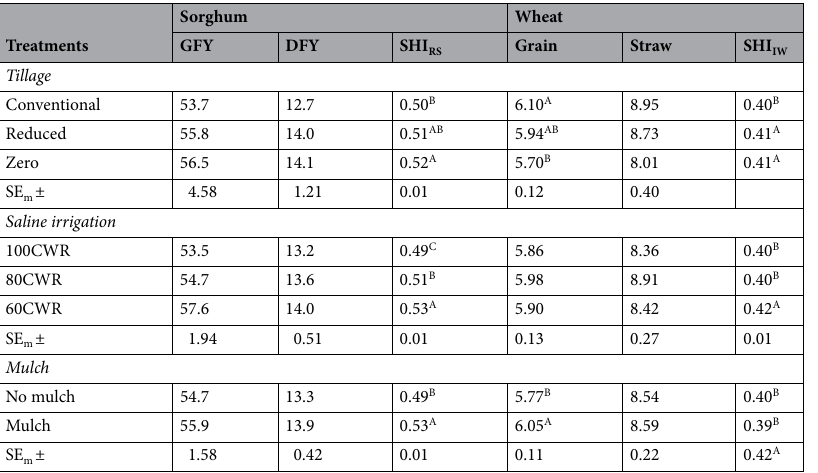
Table 4. Effect of tillage, irrigation and mulch on green fodder yield (GFY) and dry fodder sorghum yield (DFY) and wheat grain and straw yield (Mg ha −1 ) and weighted linear soil health index (SHI). Different uppercase letters (A, B) denote significant differences ( P < 0.05, Tukey’s HSD test). Data are means over 2 years. CWR: Per cent water requirement for wheat, irrigation applied only in wheat, sorghum was grown as rainfed; SE m ± : standard error. SHI for sorghum (SHI RS ) = ∑ [( α -glu score × 0.1) + (MBC score × 0.1) + (EC e score × 0.09) + (KMnO